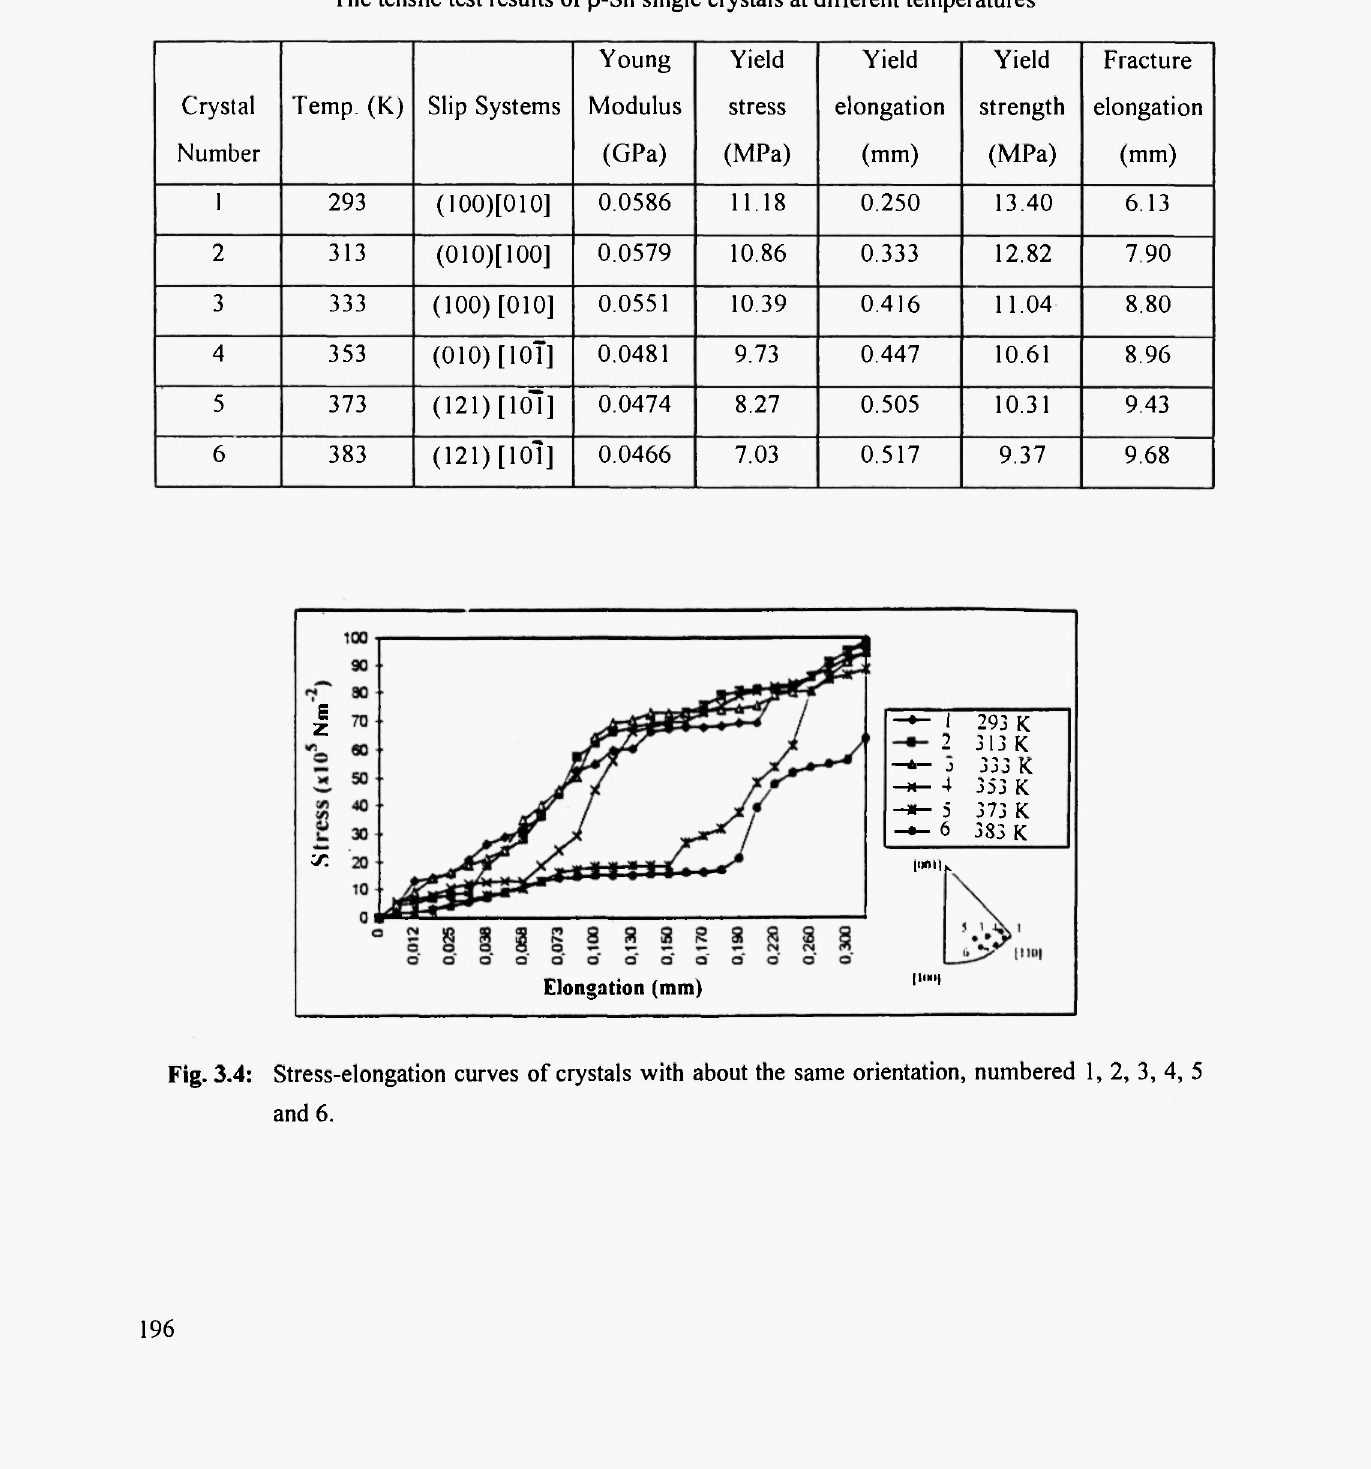
Fig. 3 .4: Stress-elongation curves of crystals with about the same orientation, numbered 1, 2, 3, 4, 5 and